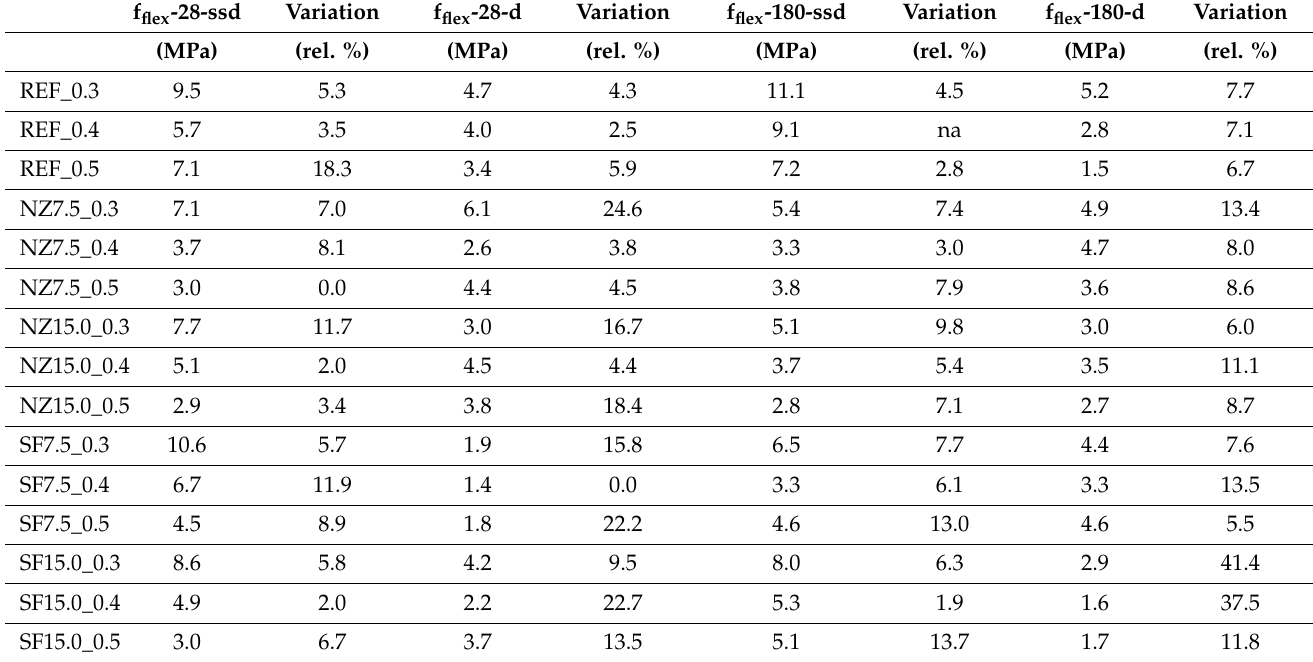
Table 5. Flexural strength